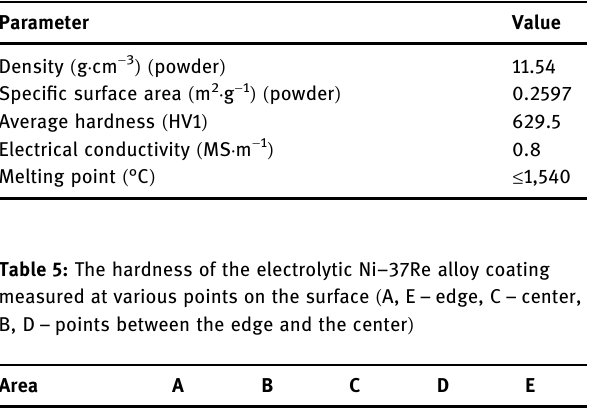
Table 4: Physical properties of the Ni – 37Re alloy coating Parameter